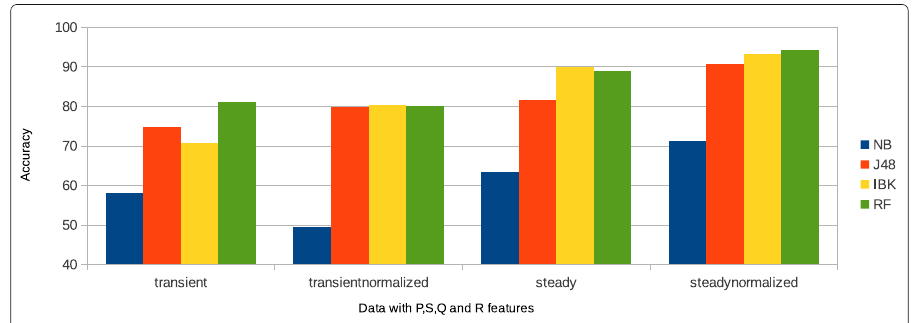
Fig. 5 Effect of Normalization on Performance of